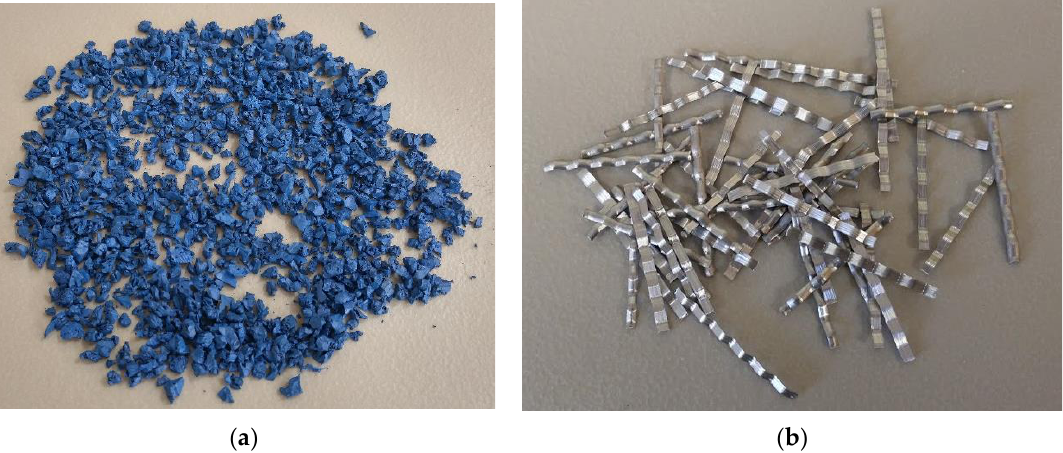
Figure 2. Crumb rubber and stainless steel fibers. ( a ) Crumb rubber. ( b ) Stainless steel fibers.